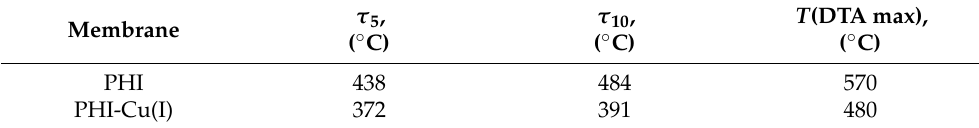
Table 2. Characteristics of thermal stability of the membranes.